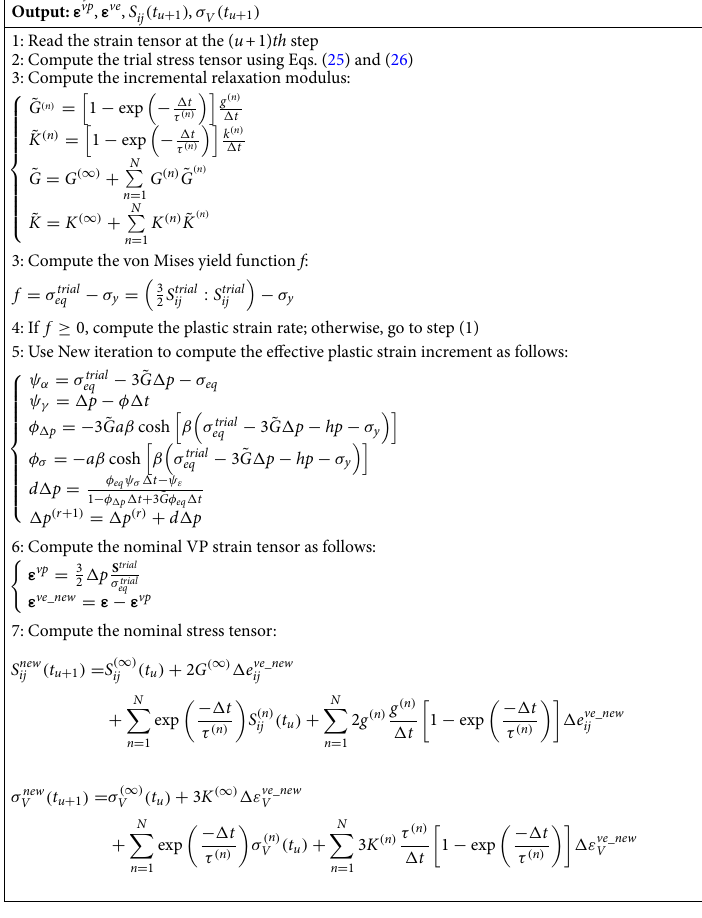
Table 1. VE–VP algorithm.